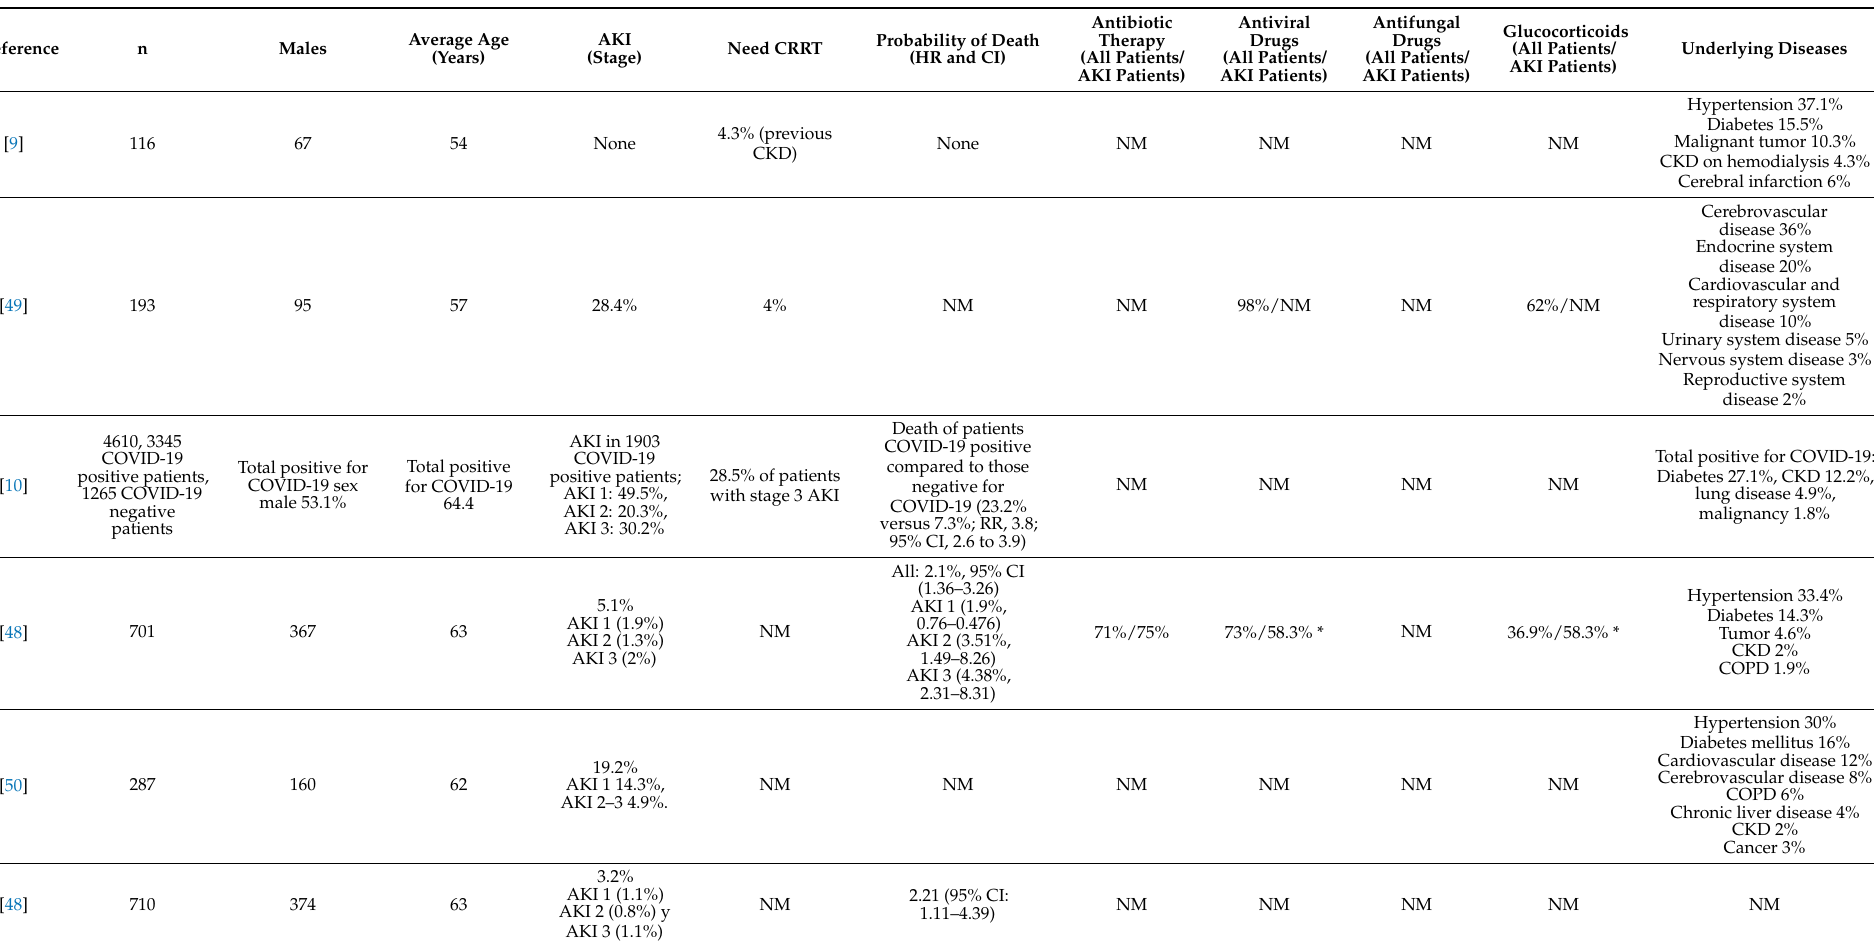
Table 1. Main characteristics observed in COVID-19 AKI